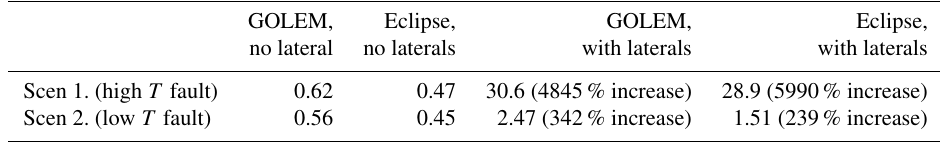
Table 5. Injectivity index (m 3 h − 1 MPa − 1 ) without radials and with laterals connecting to the fault and the increase from laterals.